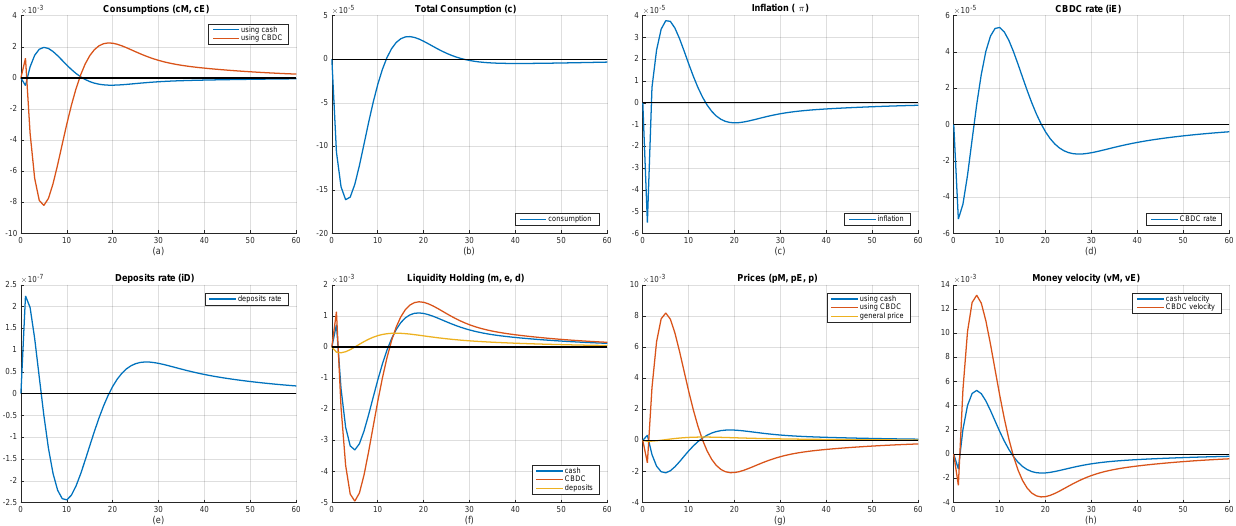
Figure 2. The effect of negative shock of CBDC transaction cost on ( a ) consumption by using cash c M and CBDC c E , ( b ) total consumption c t , ( c ) inflation π t , ( d ) CBDC rate i E t t ( f ) liquidity holding m t , e t , d t , ( g ) prices p M − e t = c E v E t t